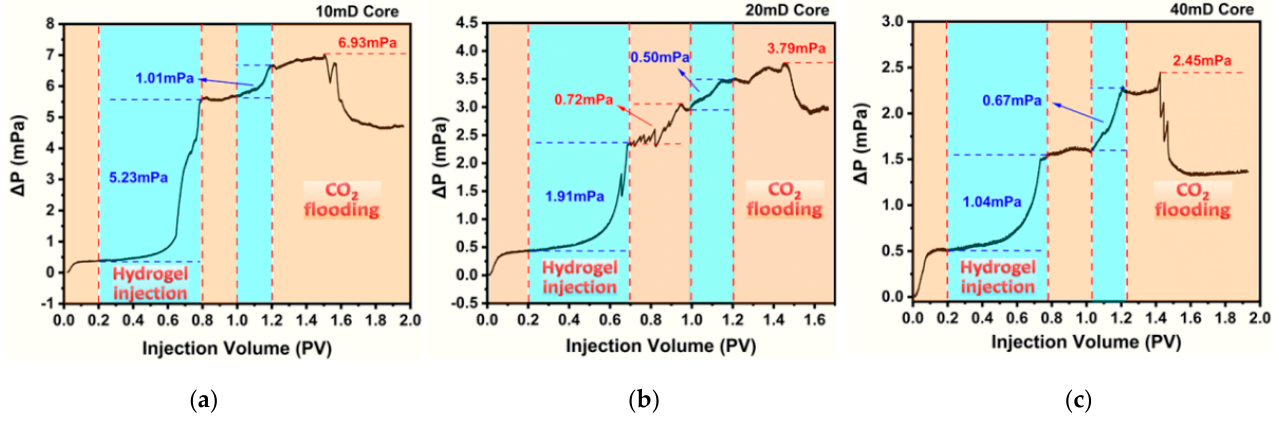
Figure 6. Plugging experiment with different matrix permeability cores under the environmental condition of 50 °C and pH 10.0. ( a ) 10 mD core, ( b ) 20 mD core, and ( c ) 40 mD core.